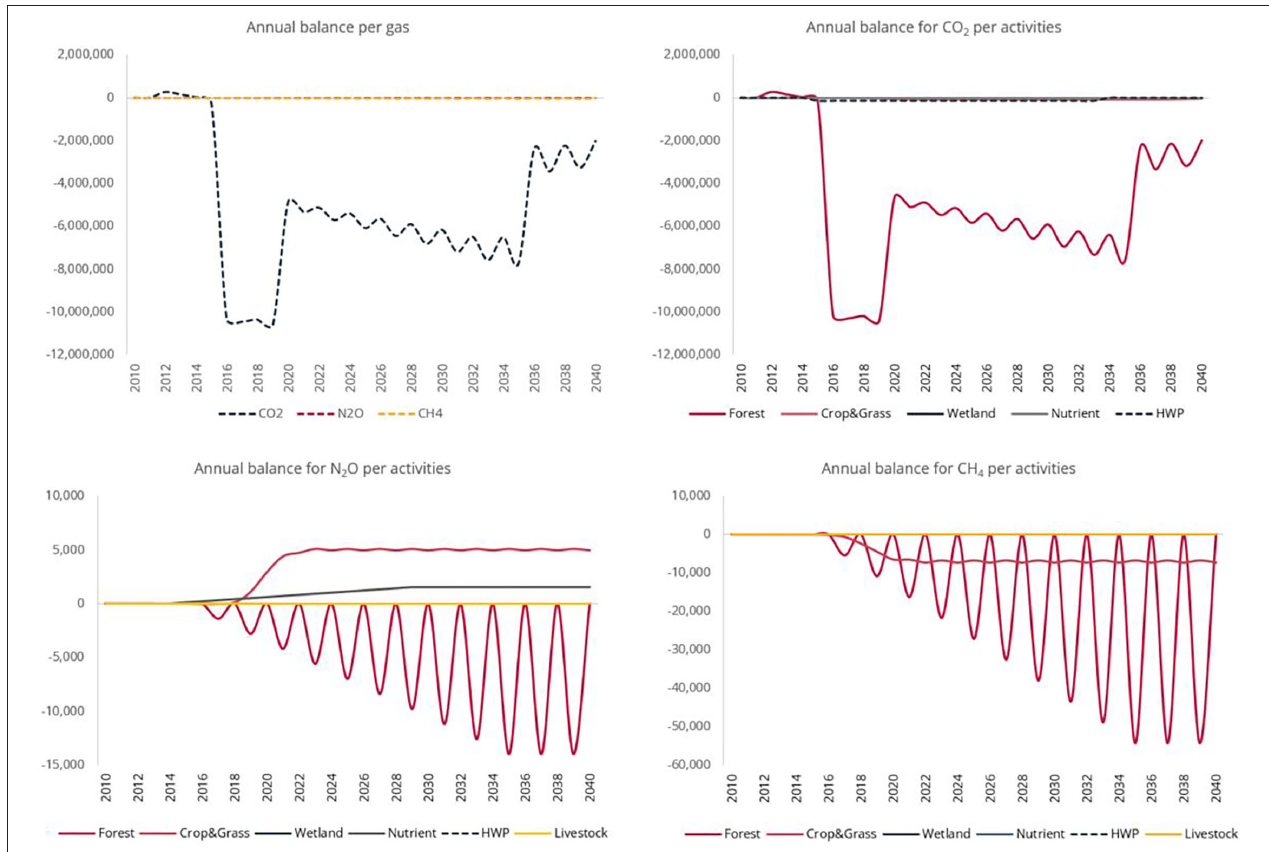
FIGURE 6 | Screenshot of the NEXT dashboard on annual GHG emissions for the balance, per gas, and per gas per activities. Emissions are in tCO 2